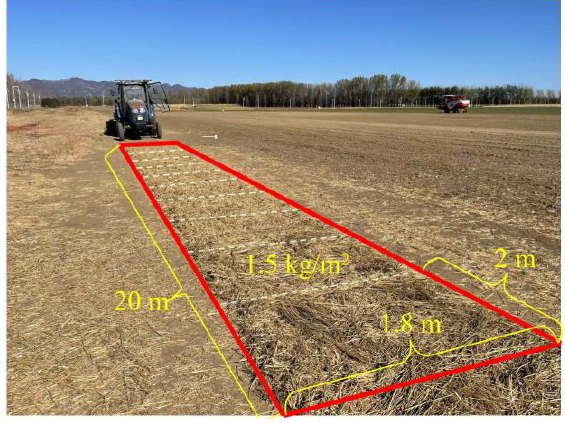
Figure 5. Test site.